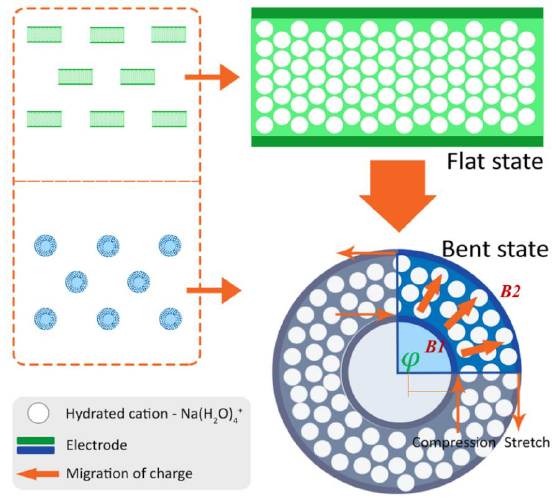
Figure 1. Electricity generation of ionic polymer–metal composites (IPMCs) under force impact.